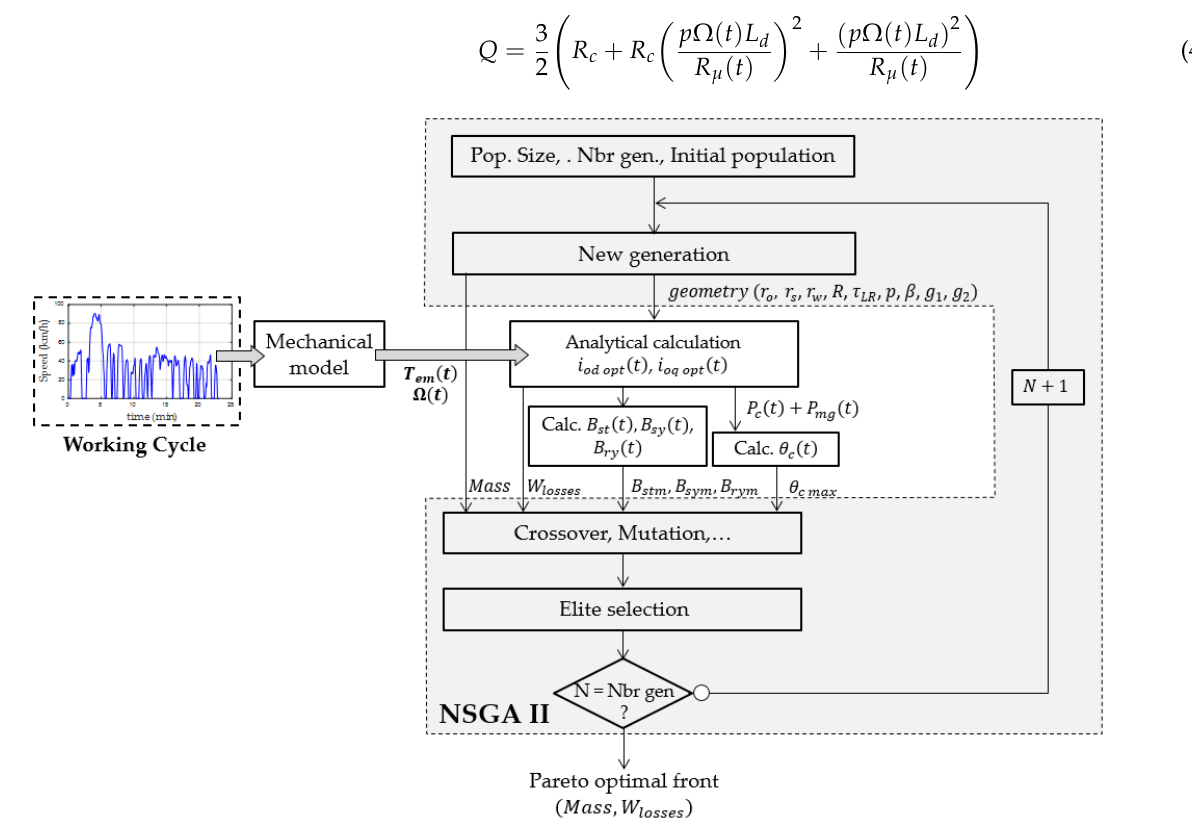
Figure 5. General flowchart of the optimization process.